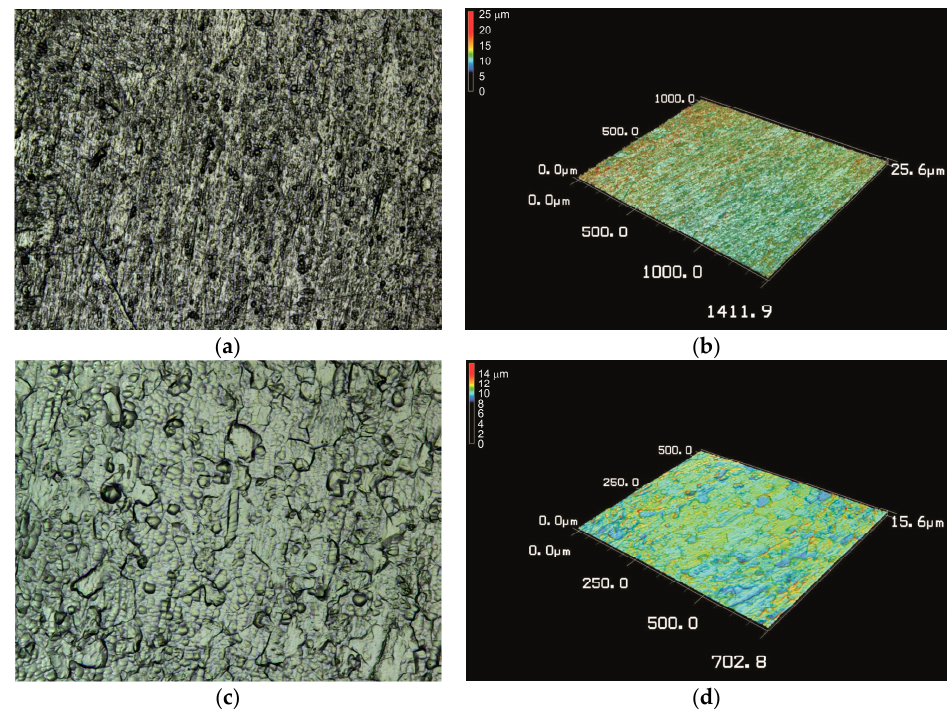
Figure 7. Laser microscope images of the tantalum surface and the results of their processing: ( a , b ), non-irradiated; ( c , d ), irradiated. The frame size is ( a , b ), 1411.9 × 1000 μ m 2 ; ( c , d ), 702.8 × 500 μ m 2 ; the height is ( b ) 25.6 μ m; ( d ) 15.6 μ m.